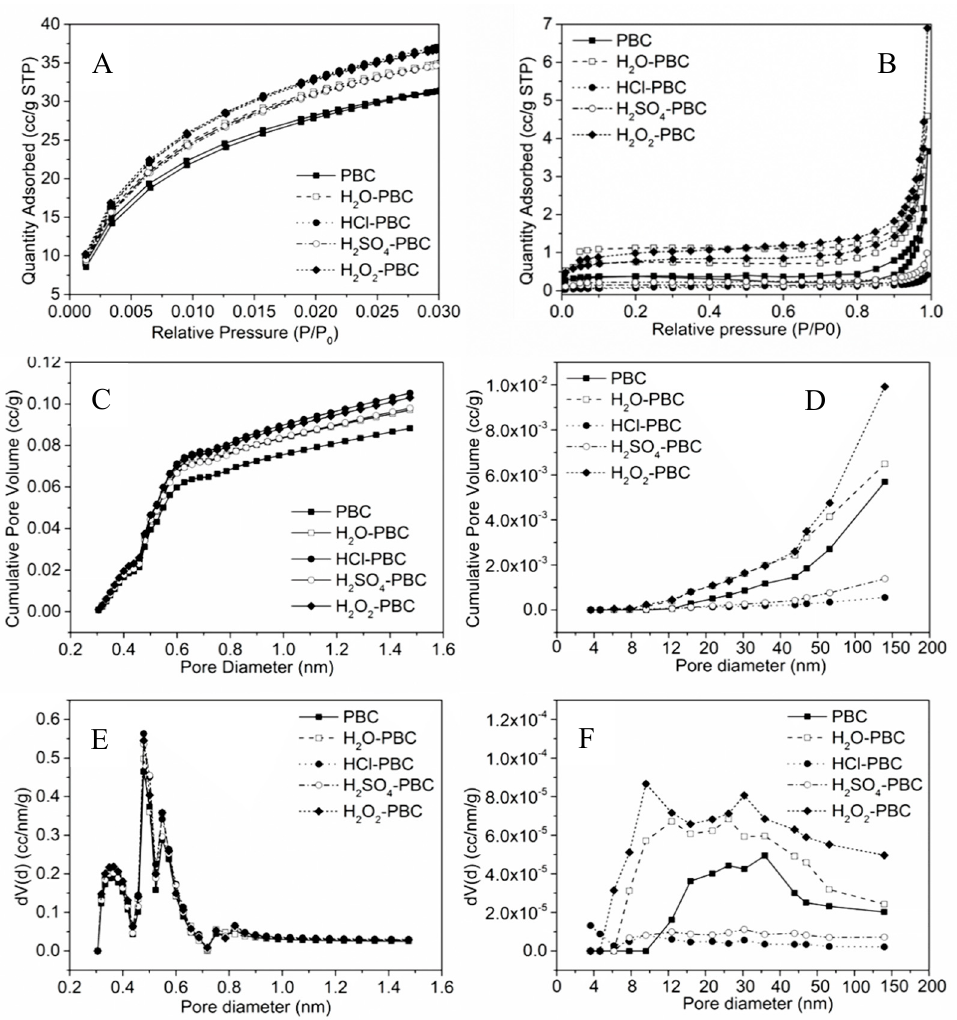
Figure 1. The gas adsorption, desorption isotherms and the distribution curves of the biochar pore size. (( A , C , E ) were adsorbed by CO 2 and ( B , D , F ) were adsorbed by N 2 .)